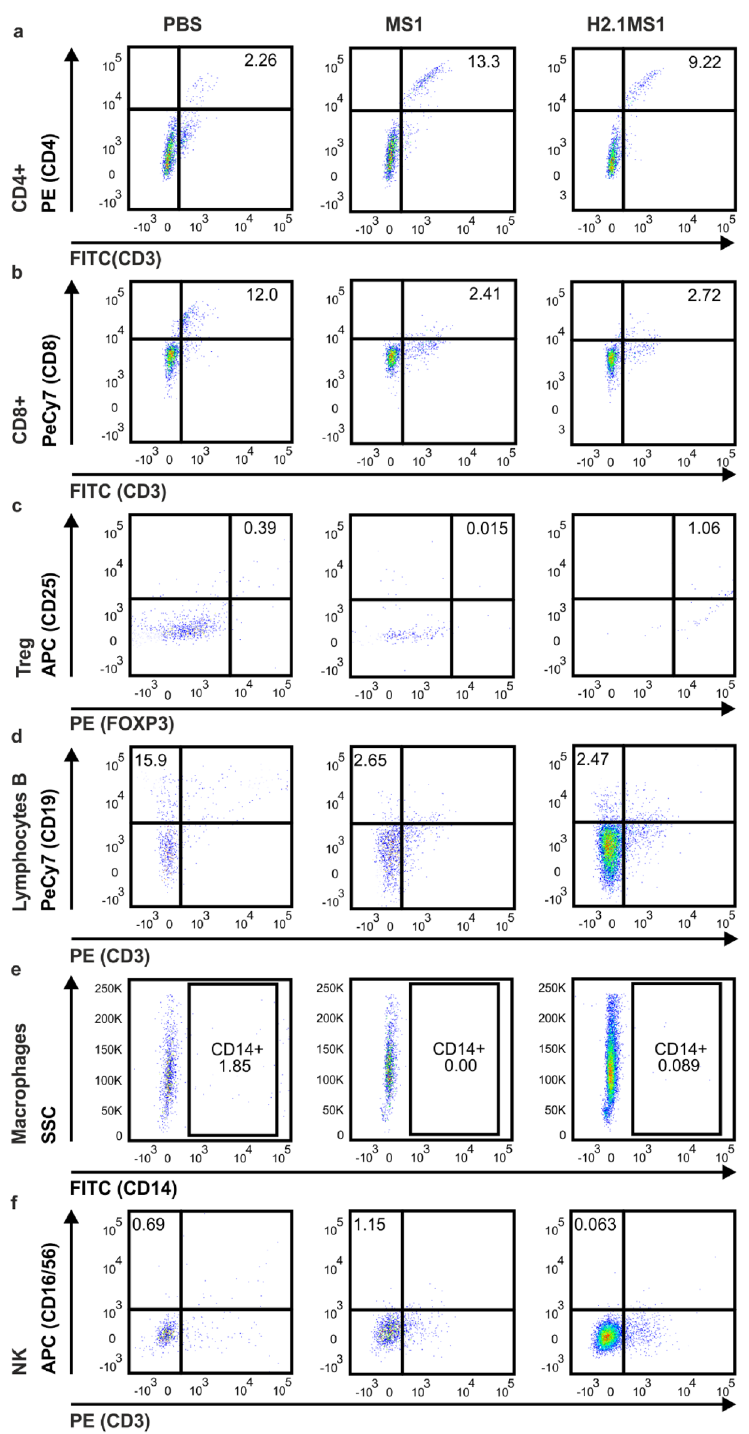
Figure 3. The phenotypes of the cells infiltrating the spheres 1 day after implantation. Mice were subcutaneously administered Matrigel loaded with PBS or MS1 or H2.1MS1 spheres, and 1 day after injection, the implants were excised and pooled among the groups; infiltrating immune cells were analyzed by flow cytometry. ( a ) CD4 + lymphocytes (CD45 + CD3 + CD4 + ), ( b ) CD8 + lymphocytes (CD45 + CD3 + CD8 + ), ( c ) T reg lymphocytes (CD45 + CD3 + CD25 + FoxP3 + ), ( d ) B lymphocytes (CD45 + CD3 − CD19 + ), ( e ) macrophages (CD45 + CD14 + ), and ( f ) NK cells (CD45 + CD3 − CD16/56 +